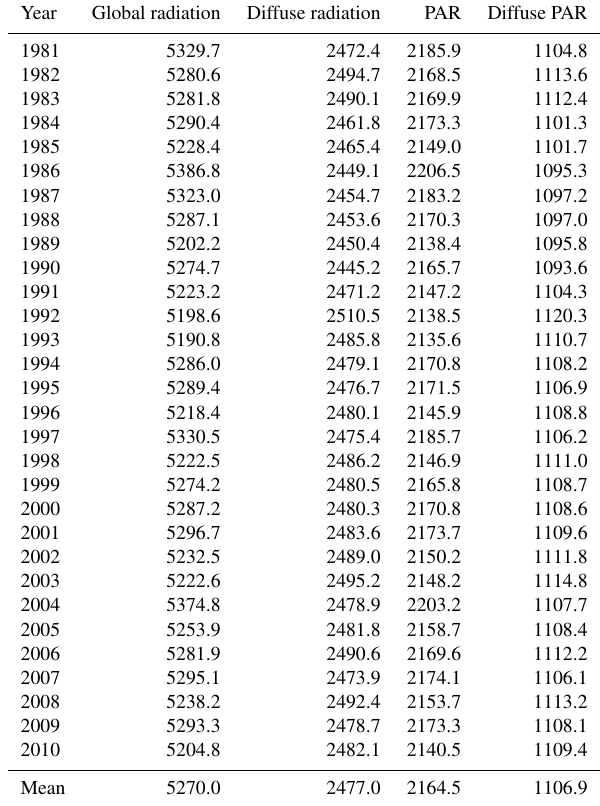
Table 1. Global radiation, diffuse radiation, PAR, and diffuse PAR in China for each year. Units are MJm − 2 yr − 1